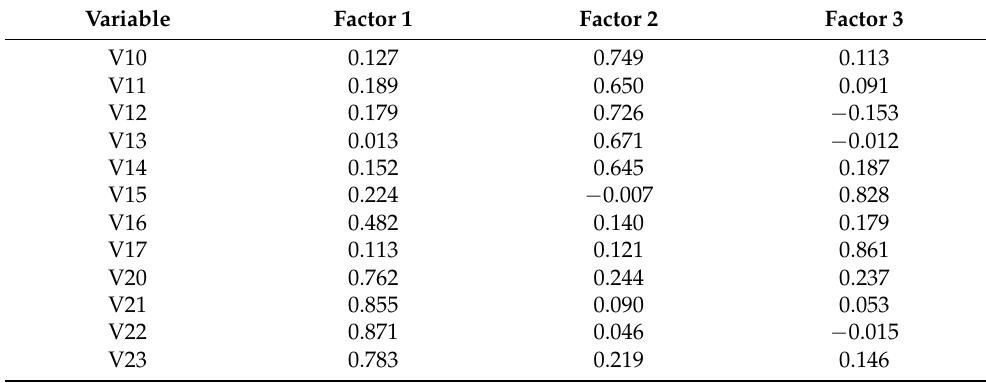
Table 2. Factor loads after varimax rotation with Kaiser